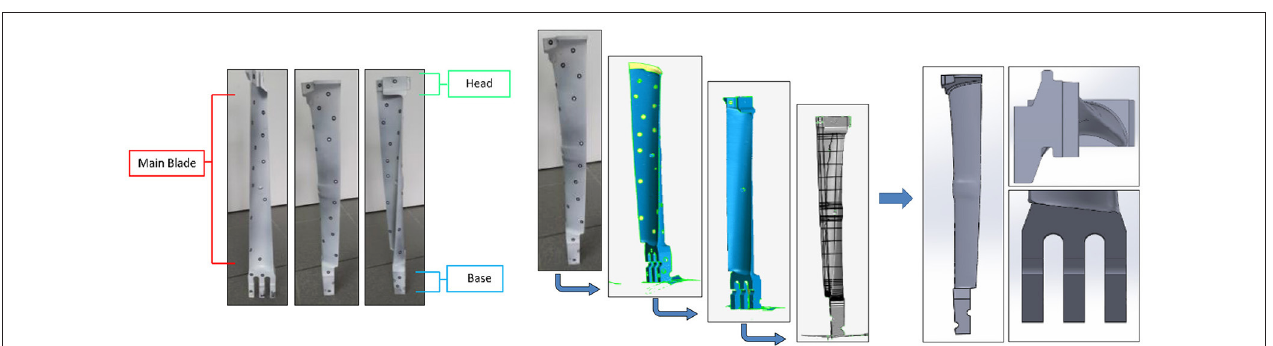
Frontiers in Built Environment |